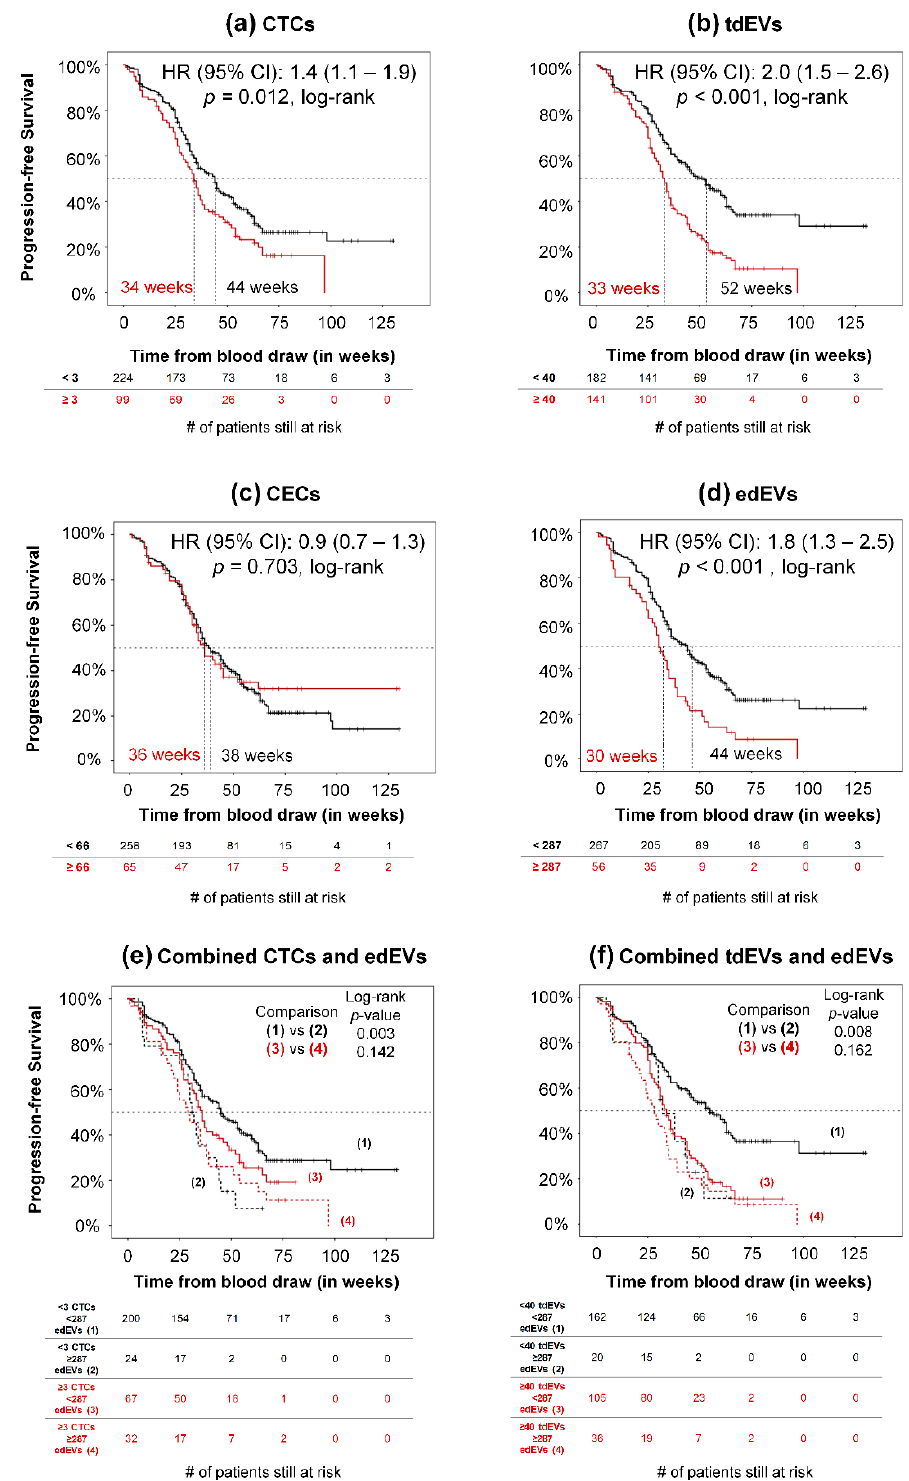
Figure 4. Association of CTCs ( a ), tdEVs ( b ), CECs ( c ), edEVs ( d ), combined CTCs and edEVs ( e ), and combined tdEVs and edEVs ( f ) with progression-free survival (PFS) of 323 metastatic colorectal cancer (mCRC) patients before the initiation of a new therapy.